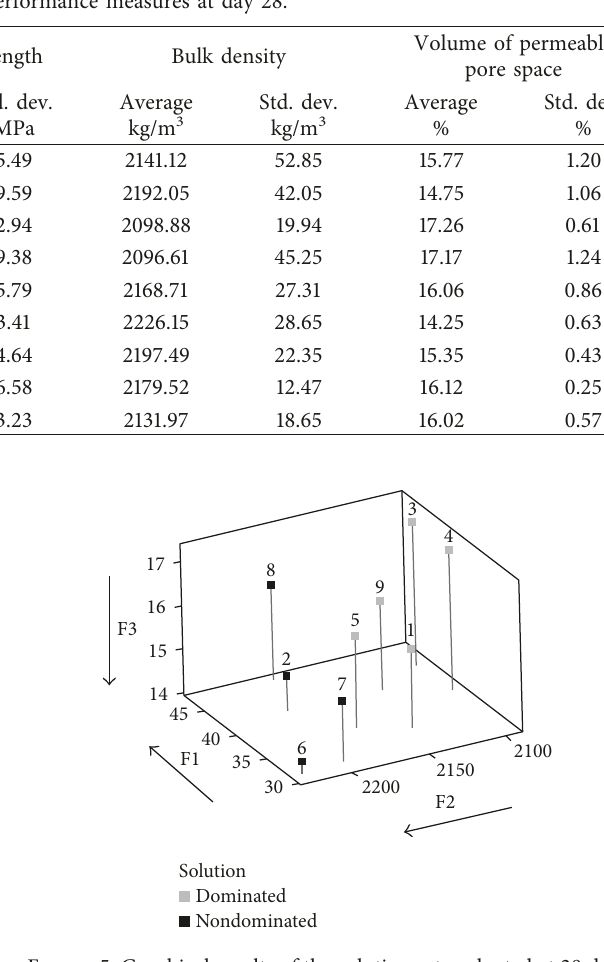
Figure 5: Graphical results of the solution set evaluated at 28 days (rotated